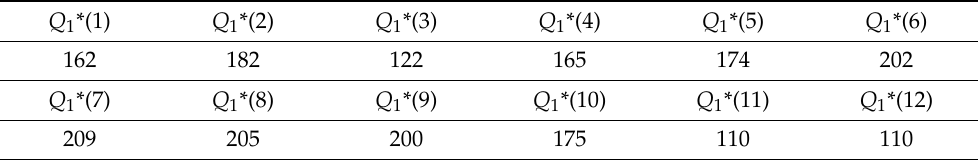
Table 12. Economical delivery plan for warehouse 1 ( τ * =